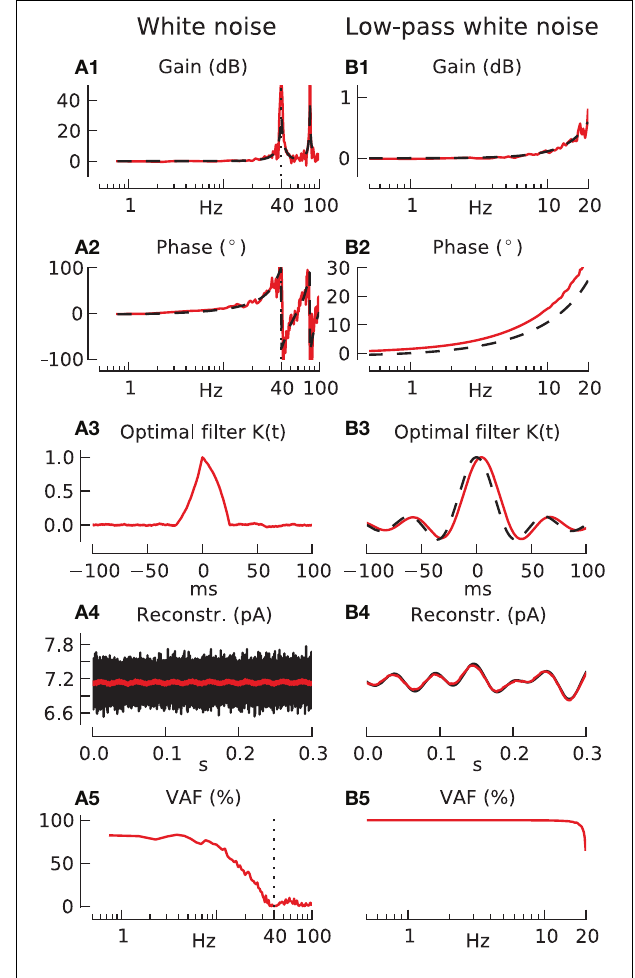
FIGURE 2 | Response of integrate-and-fire neuron to white noise stimulation using sampling-rate filter and ideal observer methods. Parameters for all following simulations: carrier-rate F 0 = 40 spikes/s, modulation amplitude a = 0 . 1. (A) Response to unfiltered white noise. (A1,A2) Show transfer function gain and phase respectively (red line), compared with analytically derived response (black dashed line). (A3) Shows the optimal filter for unfiltered white noise, (A4) the results of its use in a sample reconstruction (black shows input, red shows output), and (A5) the reconstruction quality (VAF). (B) Response to white noise low-pass filtered at 20Hz. (B1–B5) as in (A) . The black dashed line in (B3) is the (cid:5) (cid:6) 2 π · 20 Hz · t , which is the Fourier transform of the function f ( t ) = sinc 20Hz white noise